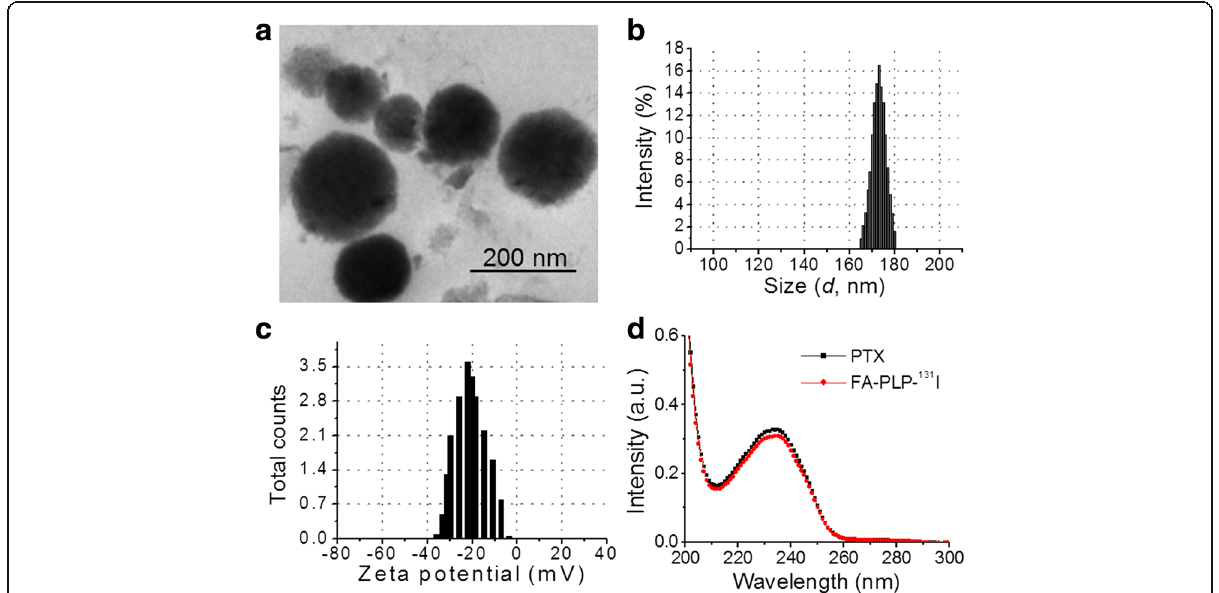
Fig. 2 a TEM image of FA-PLP- 131 I. b Particle size and c zeta potential of FA-PLP- 131 I analyzed by dynamic light scattering. d Absorbance spectra of free PTX and FA-PLP- 131 I